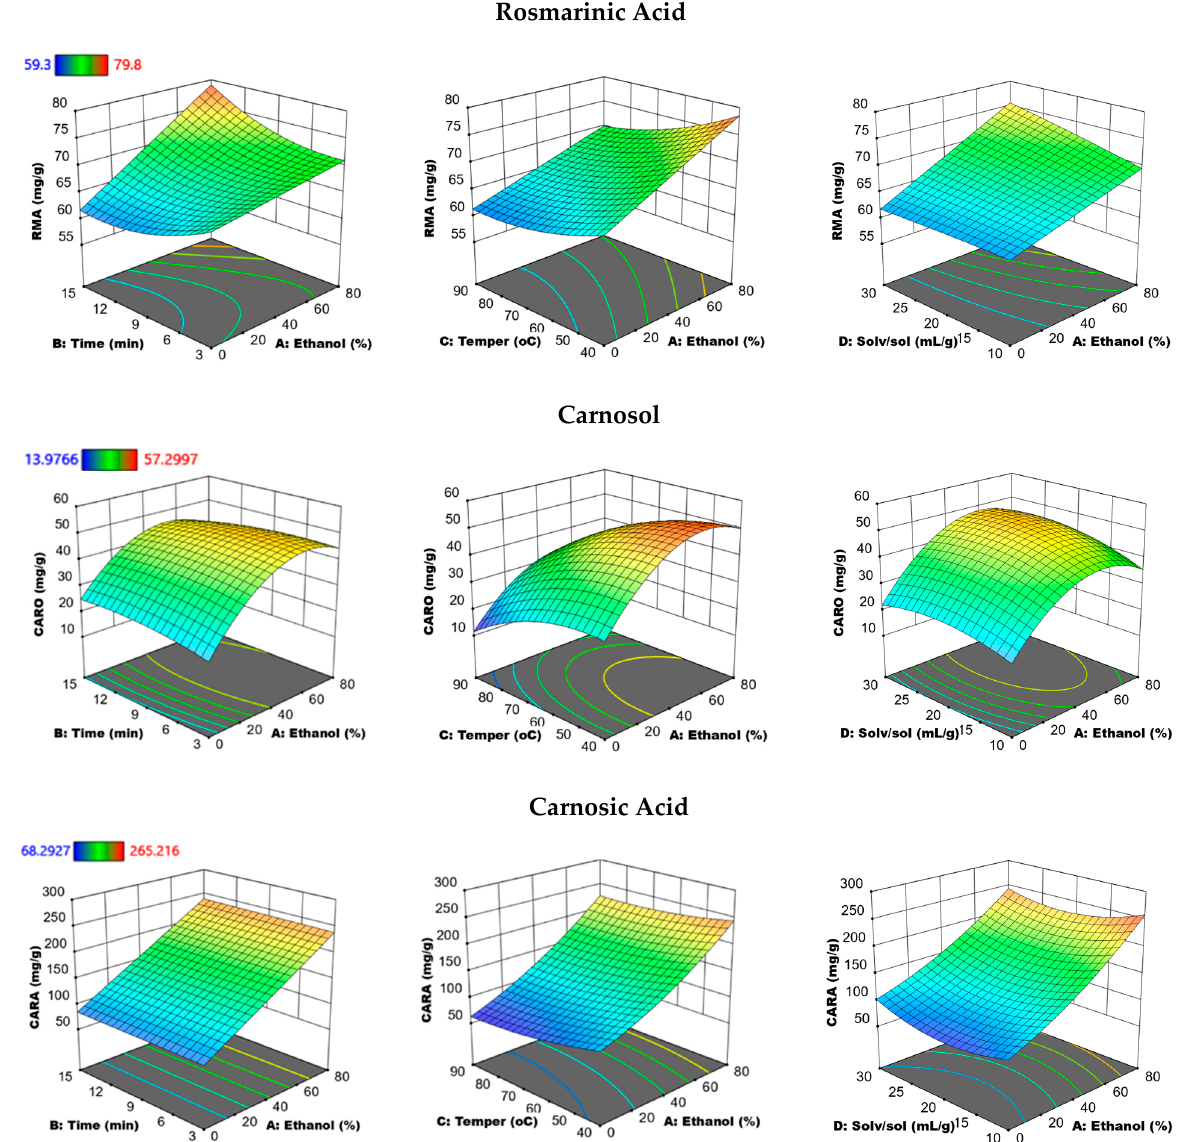
Figure 3. Response surface plots showing the combined effects of the MAE parameters (% ethanol-time, % ethanol-temperature, and % ethanol solvent-to-solid ratio) on rosmarinic acid (RMA), carnosol (CARO), and carnosic acid (CARA) by keeping the two independent variables constant at medium levels.